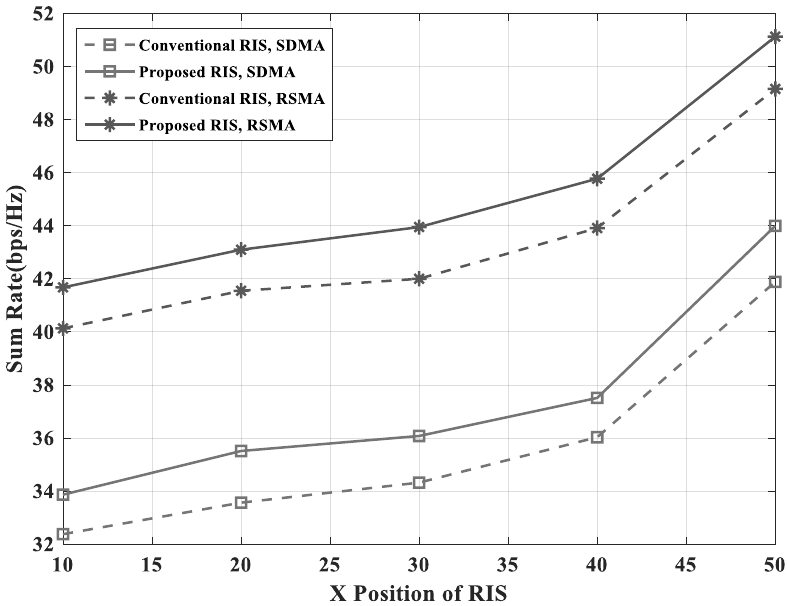
Figure 6. Sum-rate versus X position of the RIS with N G = 4 and N I =